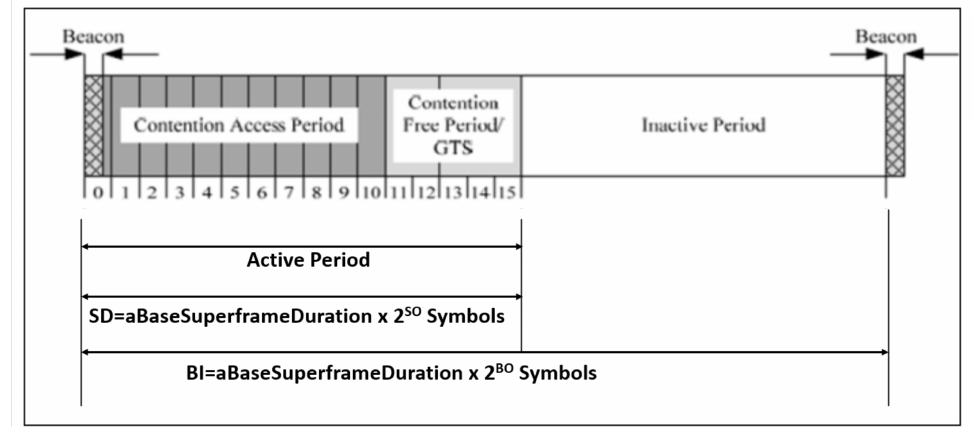
Figure 4. Beacon enable mode-based IEEE 802.15.4 communication